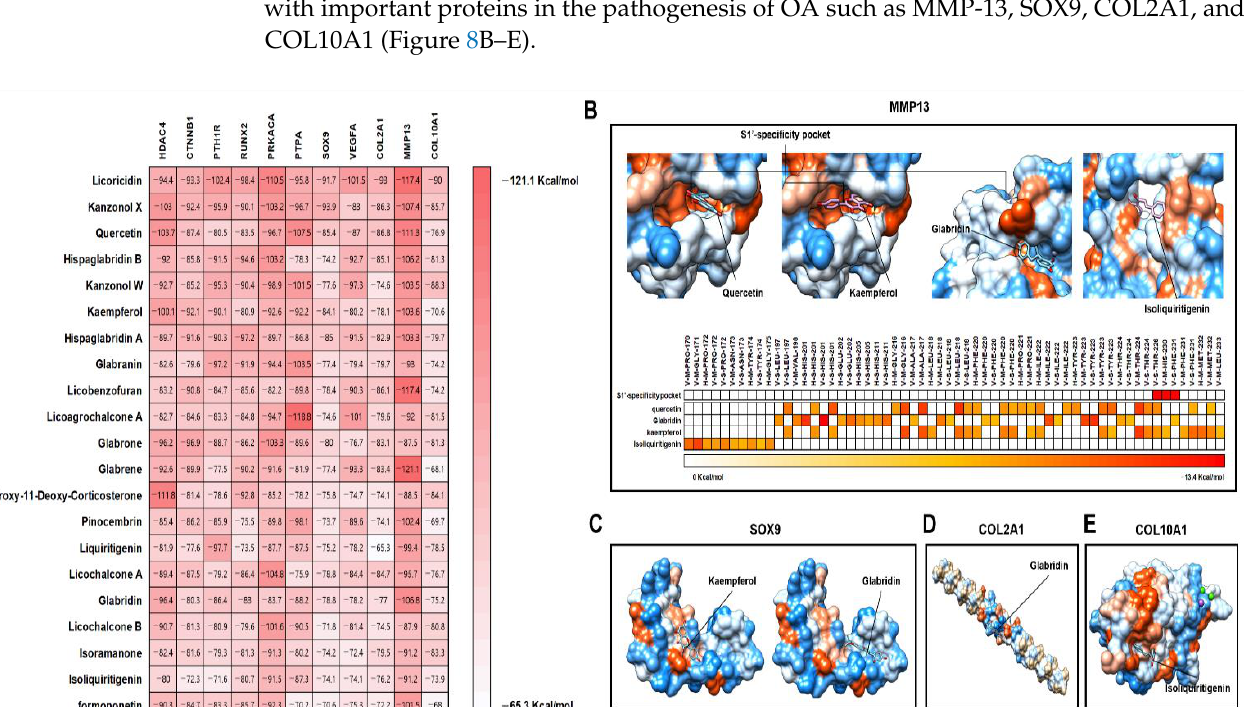
Figure 7. The 21 active compounds of licorice and its targets in ( A ) Wnt-signaling pathway and ( B ) endochondral ossifi- cation. ( C ) Representation of 21 active compounds and their targets (red: targeted and black: non-targeted). ( D ) The num- ber of targeted genes in Wnt-signaling pathway or endochondral ossification according to 21 active compounds.